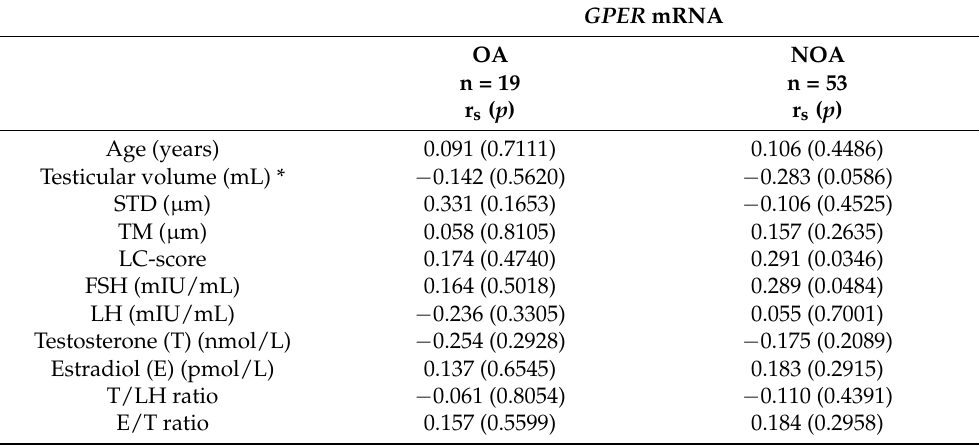
Table 5. Spearman’s rank correlation (r s ) between the GPER mRNA expression level and age, parameters of histological evaluation and hormonal levels in OA and NOA groups.